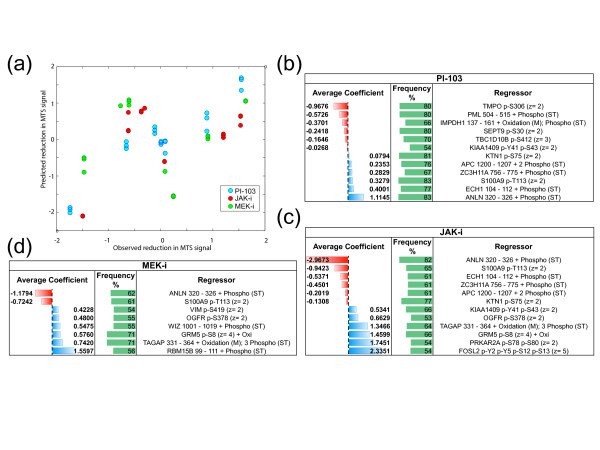
Lasso regression results. (a) Scatter plot of the viability scores predicted in the 'leave-one-cell-line-out' iterations for PI-103 (blue), JAK-i (red), and MEK-i (green) versus the observed ones. For comparability, all the scores were normalized in order to have zero mean, and unitary standard deviations. Predicted scores were normalized together with the training-set prediction in the corresponding iteration while observed scores were normalized drug-wisely. The inserts report average non-null coefficients and average non-null coefficient rate in the final descriptive models for PI-103 (b), JAK-i (c), and MEK-i (d) for phosphopeptides whose rate is > 50% (that is, sufficiently stably included in the optimal models).